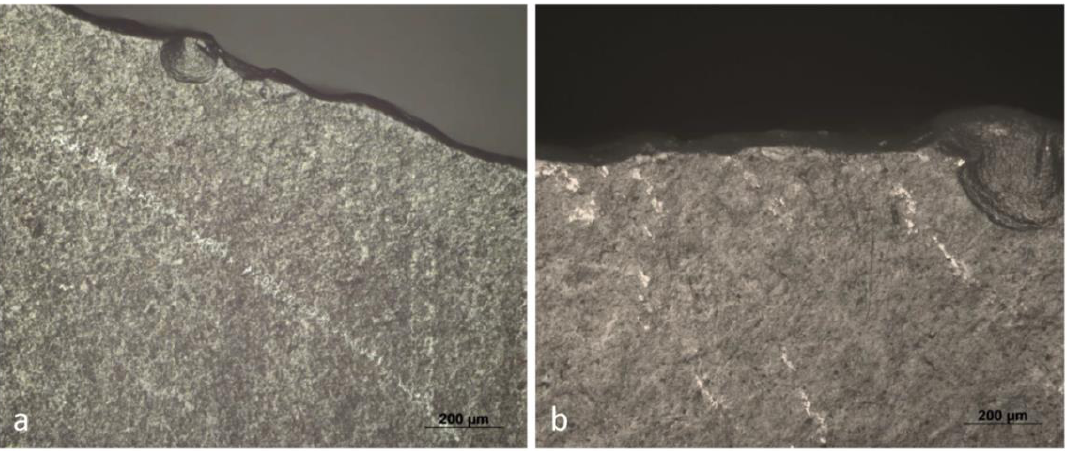
Figure 4. Microscopic details of metal traces, in the form of striations: a) on the ventral distal right edge of artefact LB25_7 (100x); b) on the ventral distal left edge of artefact LB25_24 (100x) Domestic tasks for each